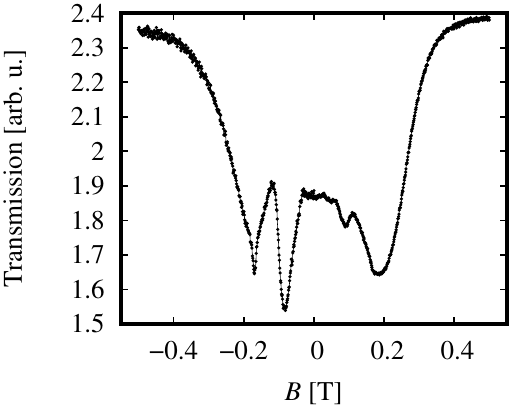
Figure 7. Transmission of 2.54 THz radiation in an experimental configuration with a circular